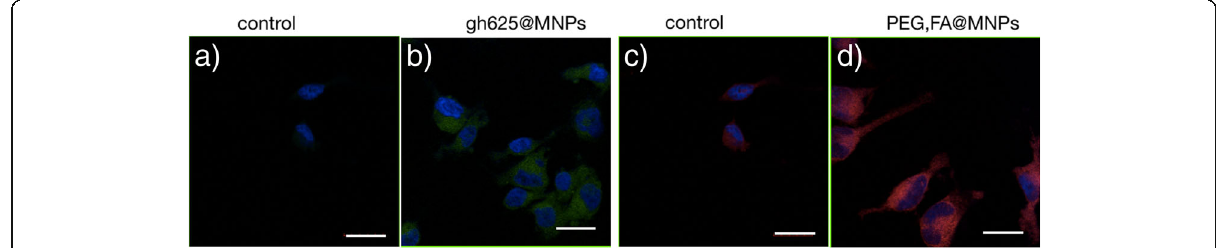
Fig. 9 LSM fluorescence micrographs of glioblastoma cells. LSM fluorescence micrographs of glioblastoma cells. Merged blue-green images: control cells ( a ) and cells incubated with 15 μ g/ml of NBD-labeled gH625@MNPs ( b ). Merged blue-red images: control cells ( c ) and cells incubated with 15 μ g/ml rhod-labeled PEG,FA@MNPs ( d ). Scale bar = 20 μ